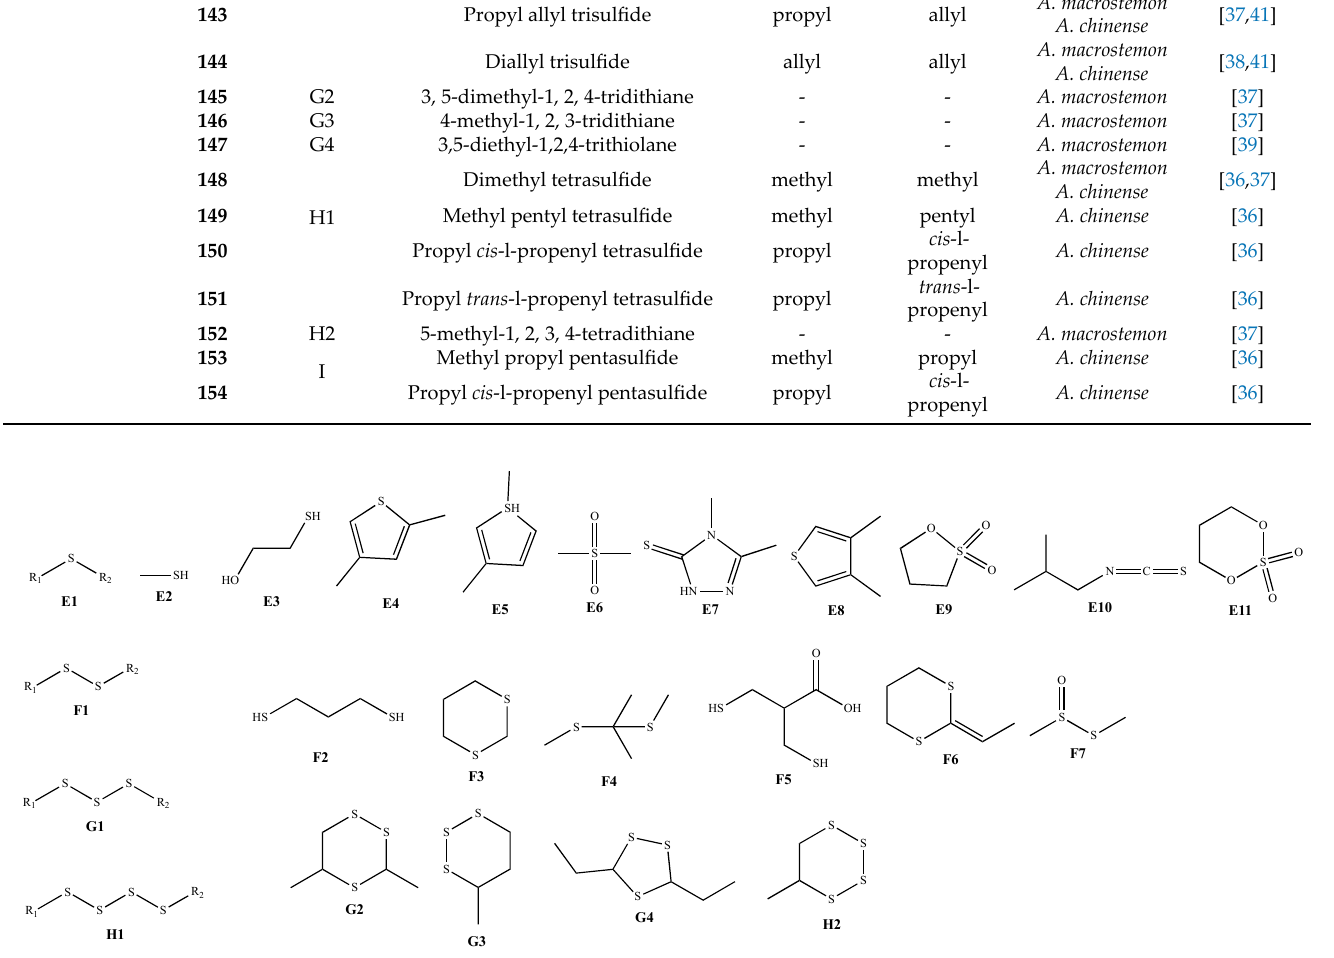
Table 6. List of nitrogen-containing compounds previously identi fi ed from AMB.